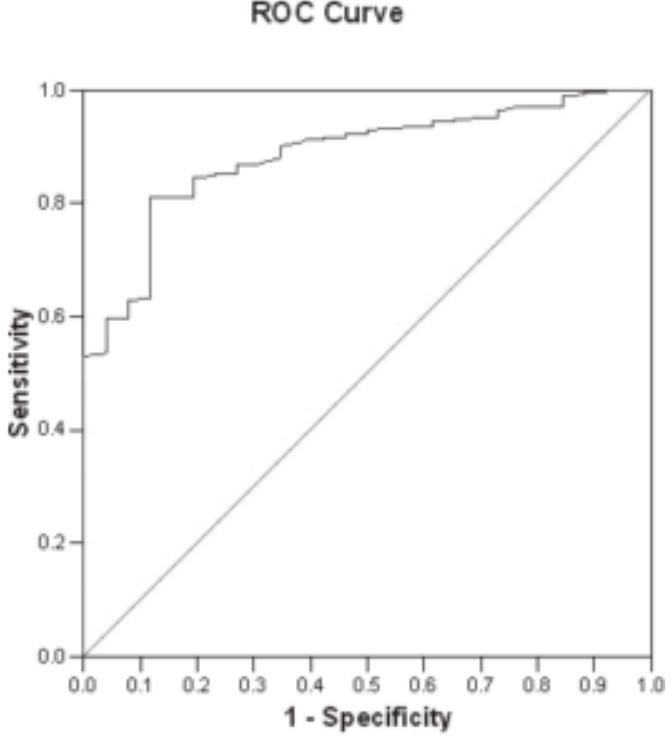
Figure 2. The receiver operating curve analysis. When 0.65 was selected as the optimum cut-off point the area under curve was 0.89 (95% confidence interval 0.75 to 0.85).